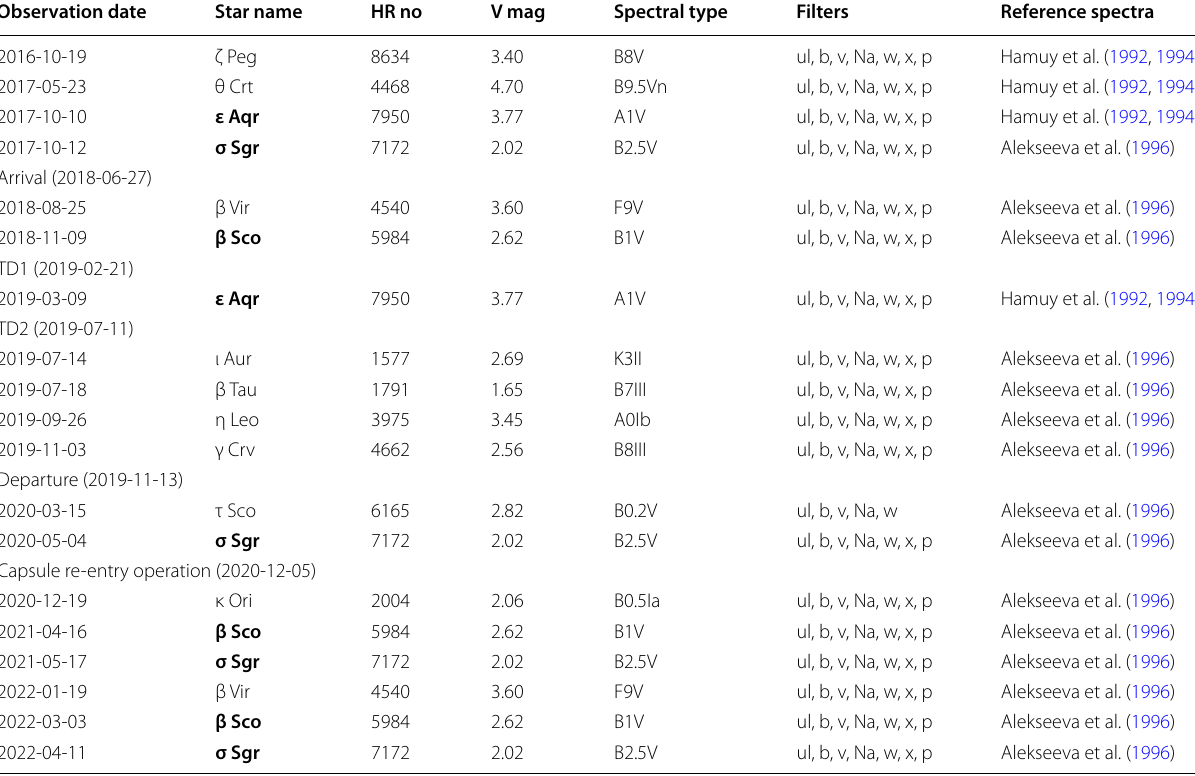
Note that ε Aqr, β Sco, and σ Sgr were observed two times, three times, and four times,